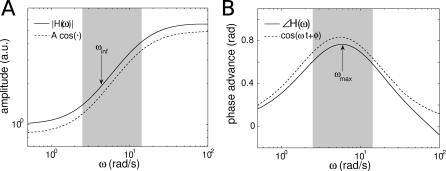
Analytical Calculations Show That the Summation of Asynchronous STD Synapses Produces Derivative-Like Postsynaptic Currents in an Identified Range of Low FrequenciesThis can be obtained from a white noise input rate (yielding the transfer function H(ω), solid lines) or from a sinusoidal input rate (dashed lines), through a different set of simplifying assumptions (see Protocol S1).(A) Amplitude of postsynaptic current fluctuations (x-axis is Fourier frequency for solid line and frequency of stimulation sinusoid for dashed curve). Amplitude is plotted in arbitrary units, ignoring all dimensional prefactors. ω
inf denotes the inflection point of the solid curve, around which a straight line is a very good approximation.(B) Phase advancement with respect to input frequency ω. ω
max denotes the frequency at which the maximum phase advancement occurs; around this point the phase is relatively insensitive to frequency ω. Dashed regions correspond to the interval [1/τD,1/τe], in which amplitude grows linearly with ω and phase remains approximately constant. Parameters used were τD = 0.4 s, Γ = 0.4, r
0 = 20 Hz.